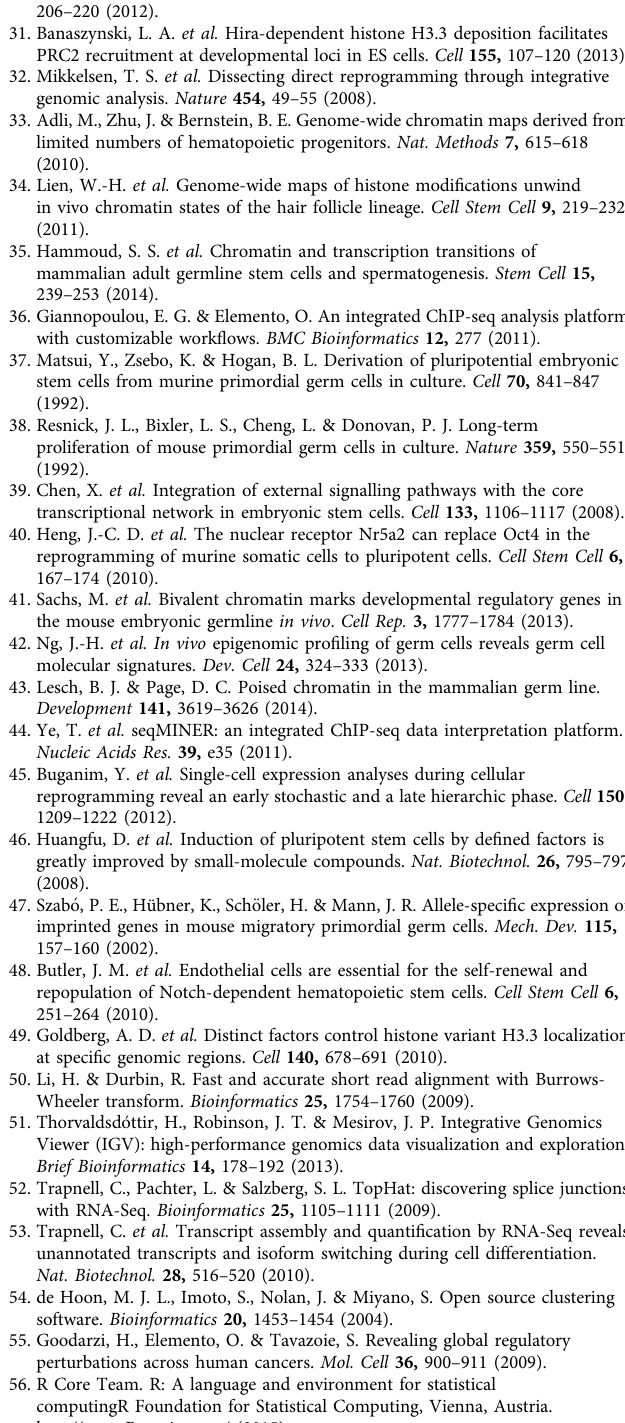
200bp. All known motifs used in our study were defined by